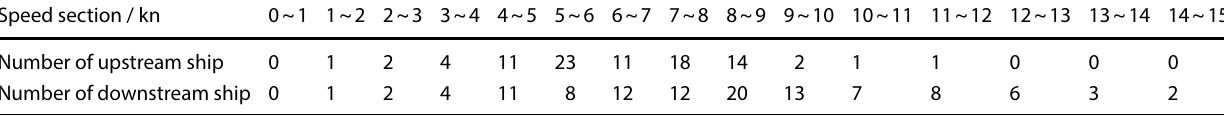
Table 5 The speed distribution of upstream and downstream ships (ves) Speed section /